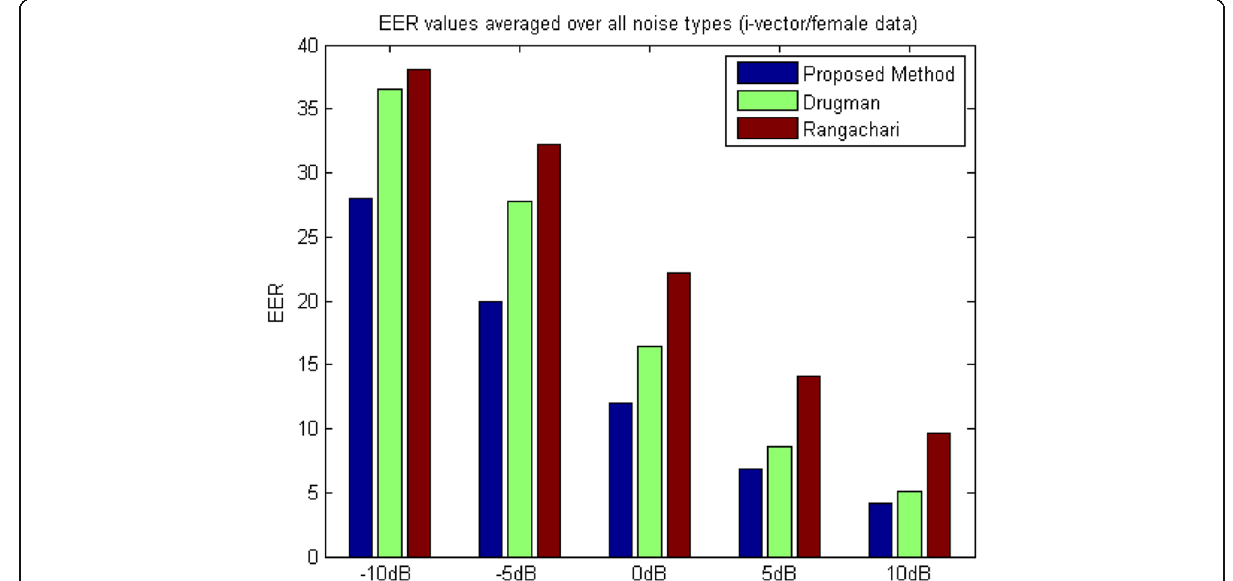
Fig. 10 EER values averaged over all noise types for the female data with i-vector